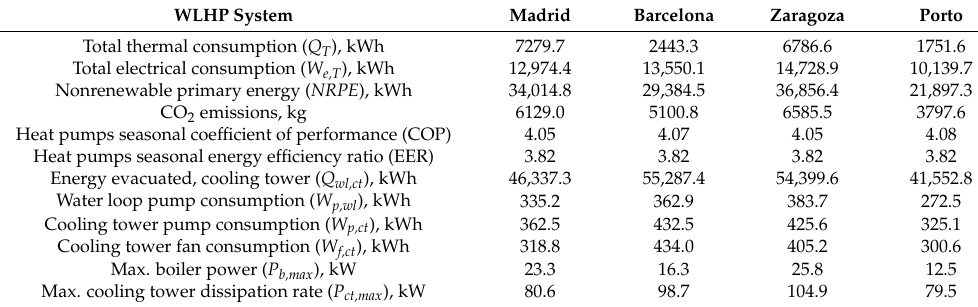
Table 2. 4-Tube Fan-coil system: Annual energy consumption and mean efficiency parameters.